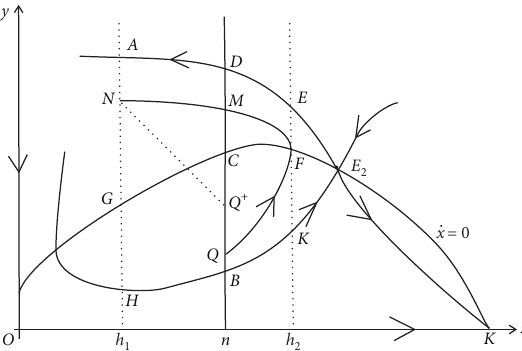
Figure 5: Illustration of the dynamics of system